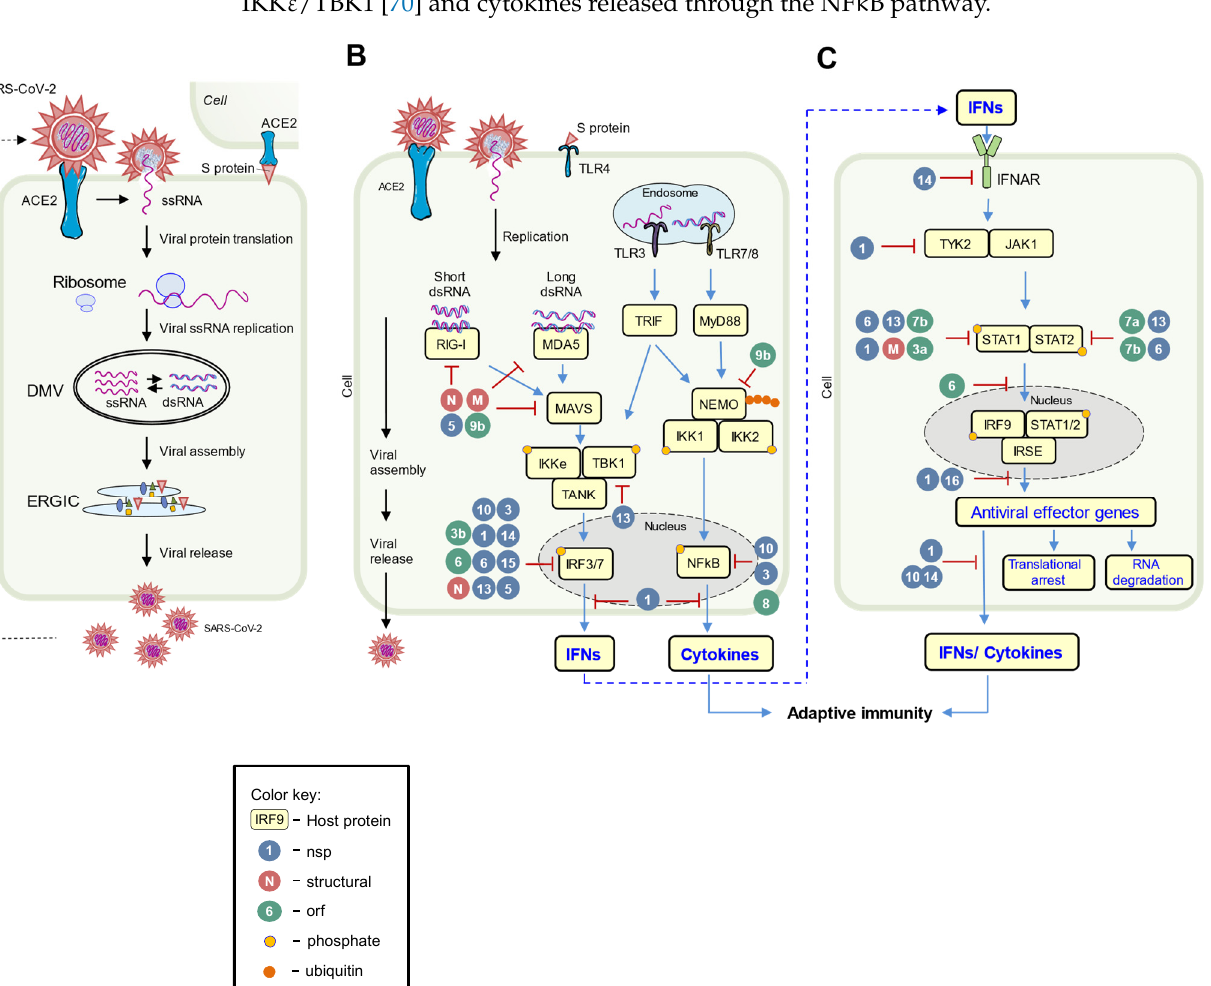
Figure 2. The replication cycle of SARS-CoV-2 and viral-host interplay. ( A ) SARS-CoV-2 enters the cell via ACE2. Viral RNA gets translated by host ribosomes and replicated within the double-membrane vesicles. The virions are assembled at ERGIC and then egressed outside the cell. ( B ) Host cell detect viral proteins and nucleic acids through PRRs and induce interferon pathway signaling. ( C ) Activated interferon response through JAK/STAT pathway inhibits viral cycle unless blocked by viral proteins. Yellow squares represent host proteins participating in antiviral response; orange dots illustrate phosphorylation events. Red circles stand for coronaviral structural proteins; green for orfs; and blue for nsps. Table 1. Immunosuppressor activity of SARS-CoV-2 proteins.